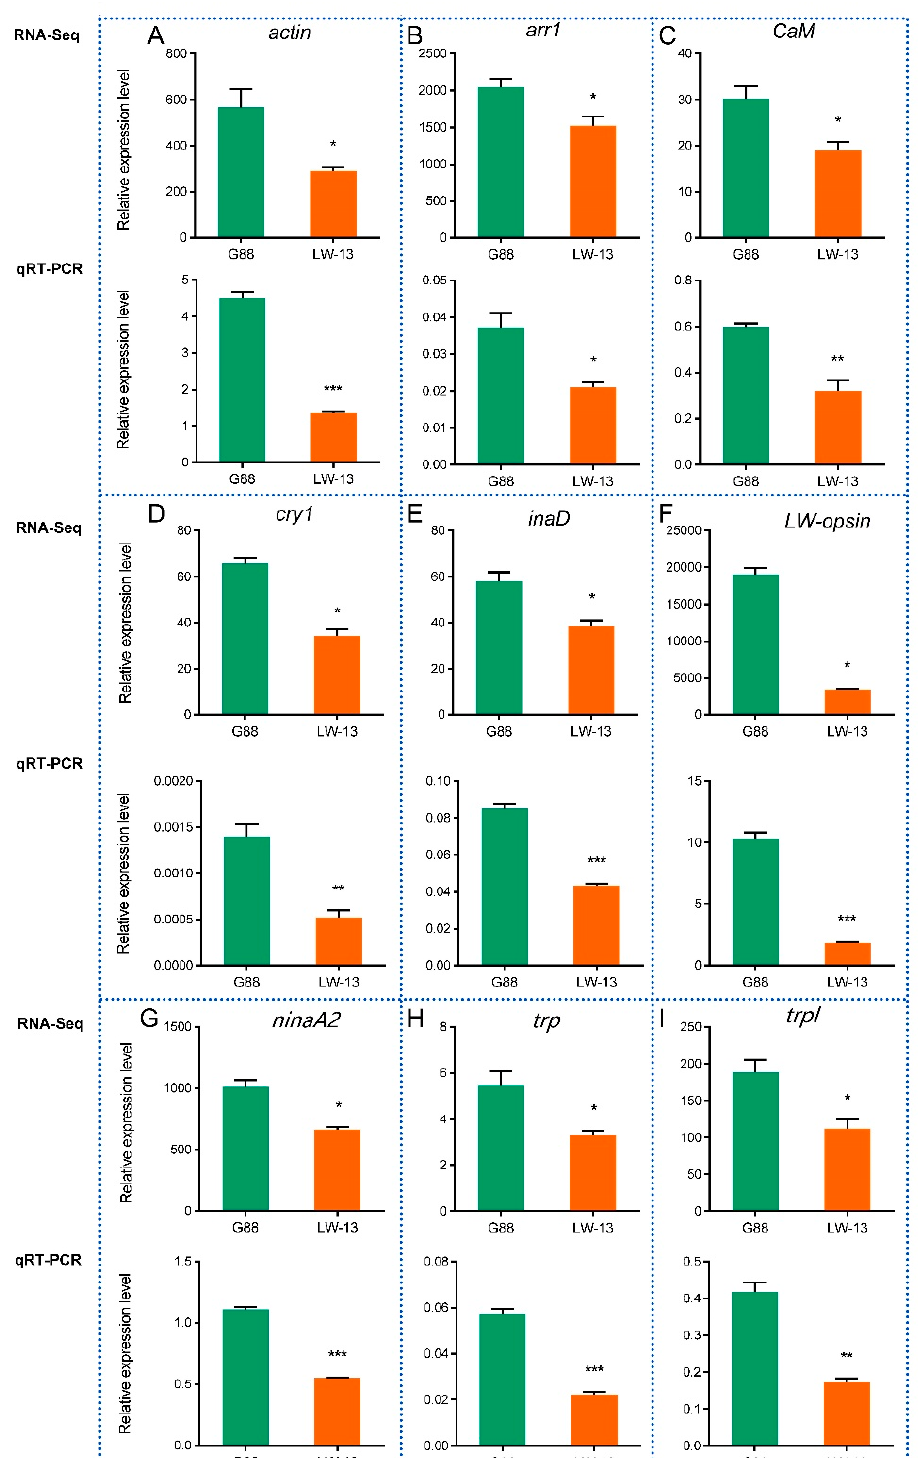
Figure 6. Verification of the expressions of 9 DEGs in LW-3 compared with G88 by RT-qPCR. ( A ) actin (gene ID, Px003840); ( B ) arr1 (gene ID, Px014948); ( C ) CaM (gene ID, Px018010); ( D ) cry1 (gene ID, Px006397); ( E ) inaD (gene ID, Px005510); ( F ) LW-opsin (gene ID, Px009837; the LW-opsin expression in LW-13 is mutant LW-opsin ); ( G ) ninaA (gene ID, Px005830); ( H ) trp (gene ID, Px009889); ( I ) trpl (gene ID, Px009888). “*” indicates P < 0.05; “**” indicates 0.01 < P < 0.05; “***” indicates P < 0.01. 3.7. The Effects of cry1 Mutation on Phototactic Behavior of P. xylostella The male P. xylostella with a 2-bp deletion in cry1 (Cry1-KO) showed higher photo- tactic rates to UV and blue lights than the male G88 (Figure 7).